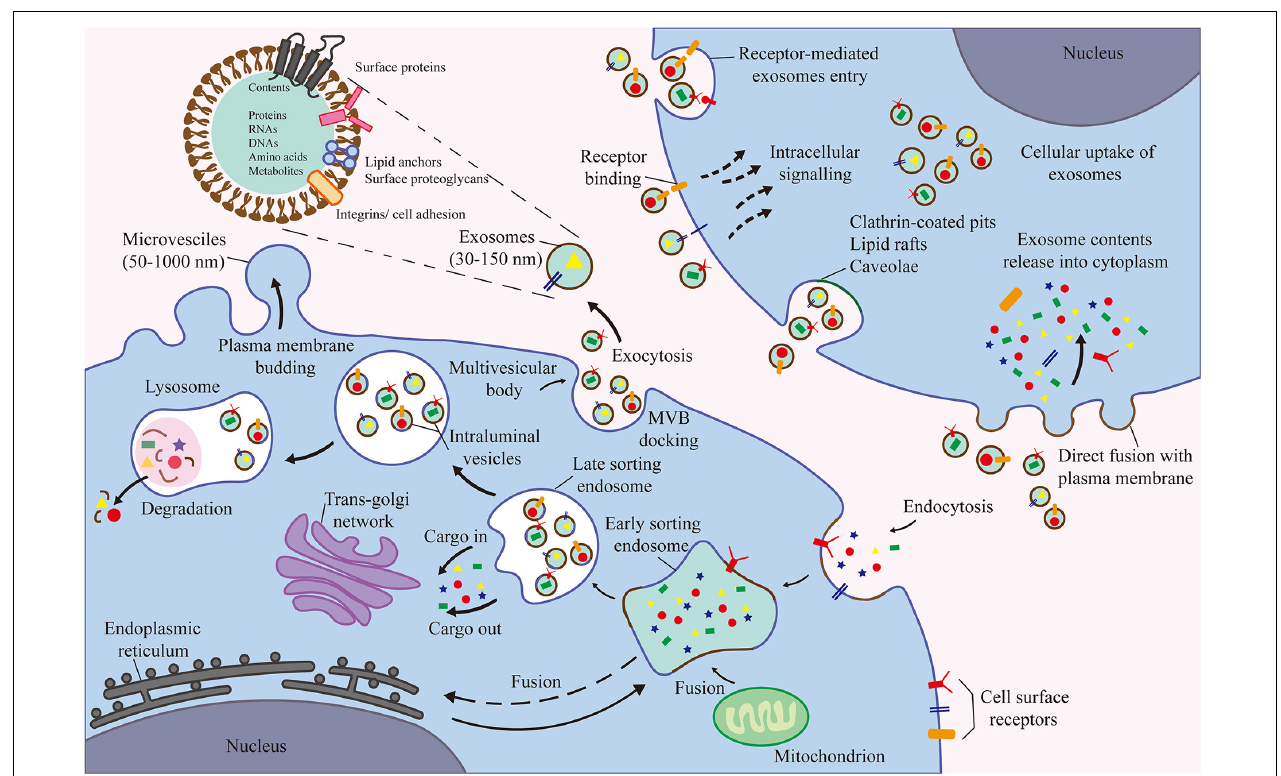
FIGURE 2 | The contents of exosomes are proteins, nucleic acids, amino acids, and metabolites. Extracellular components enter the cell through endocytosis and plasma membrane invagination. Plasma membrane buds are formed on the cavity side and fuse with the components of the endoplasmic reticulum, trans-Golgi network, and mitochondria to form early sorting endosomes. Then, the late sorting endosomes modify the cargo and produce and form various intraluminal vesicles and multivesicular bodies (MVB). Among them, some MVBs degrade after fusion with lysosomes. Other MVB can be transported to the plasma membrane to release intraluminal vesicles as exosomes outside the cell through